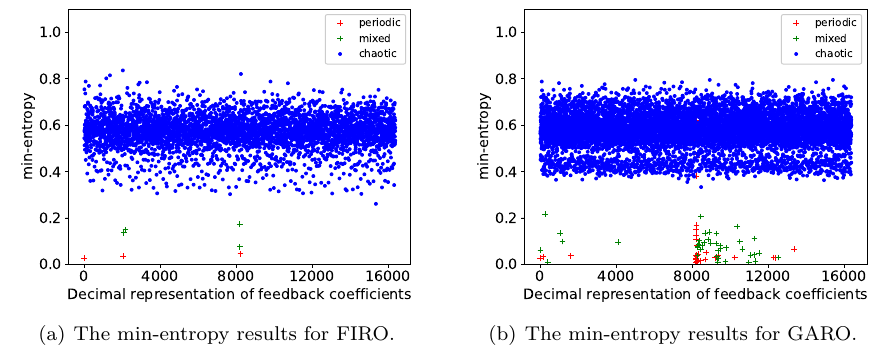
Figure 7: The min-entropy results for the implemented FIRO and GARO with periodic and chaotic